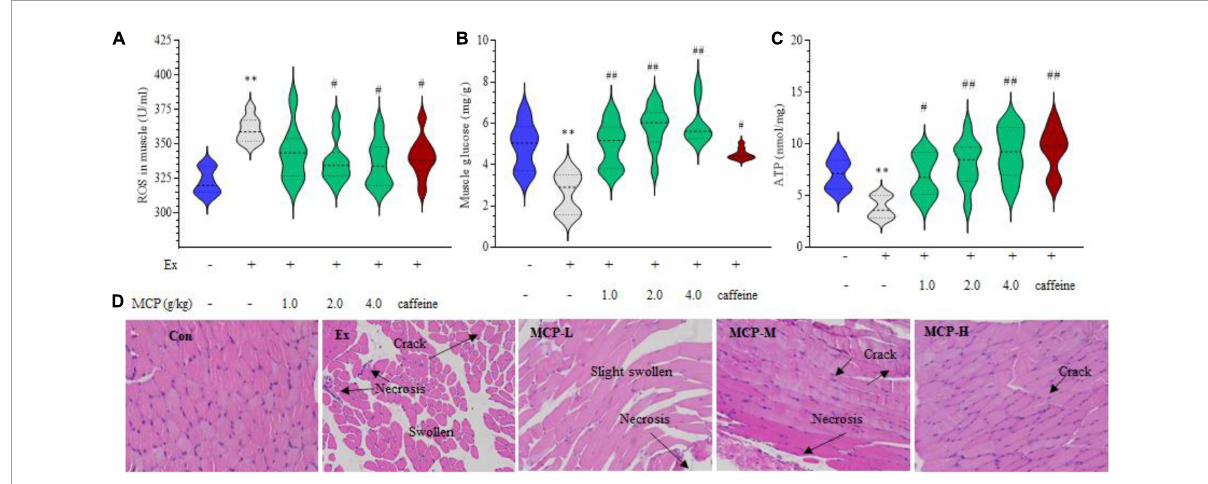
FIGURE3 Maca compound preparation (MCP) protect muscle damage from oxidative stress in exercising mice. (A) Reactive oxygen species (ROS) accumulation. (B) Glycogen contents. (C) Adenosine triphosphate (ATP) generation capacity. The content of ATP was calculated as a value relative to that in Con group, which was set as 100%. ∗∗ p < 0.01 vs control (Con) group; # p < 0.05, ## p < 0.01 vs exercise (Ex) group. (D) Hematoxylin and Eosin (H&E) stain of skeletal muscle. MCP-L, MCP-M, MCP-H represent MCP of low, moderate, and high dose